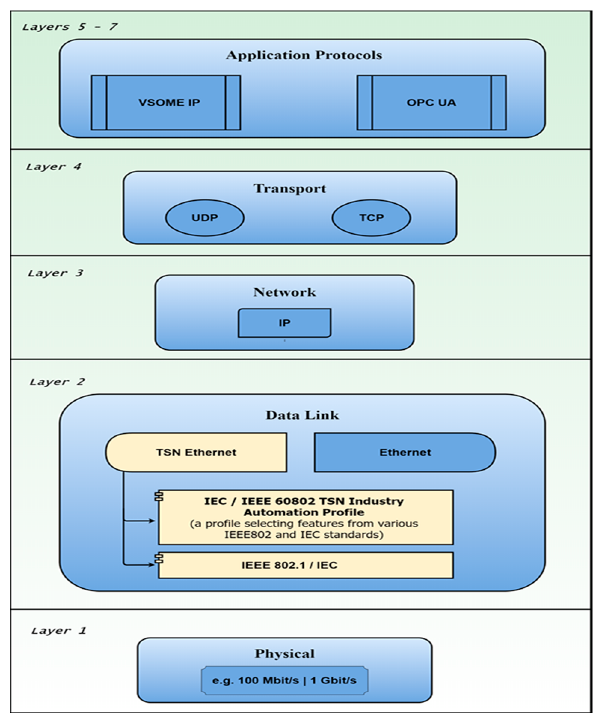
Figure 1. OPC UA and VSOME / IP application protocols in relation UDP, TSN, Raw Ethernet, in the context of the OSI layers.